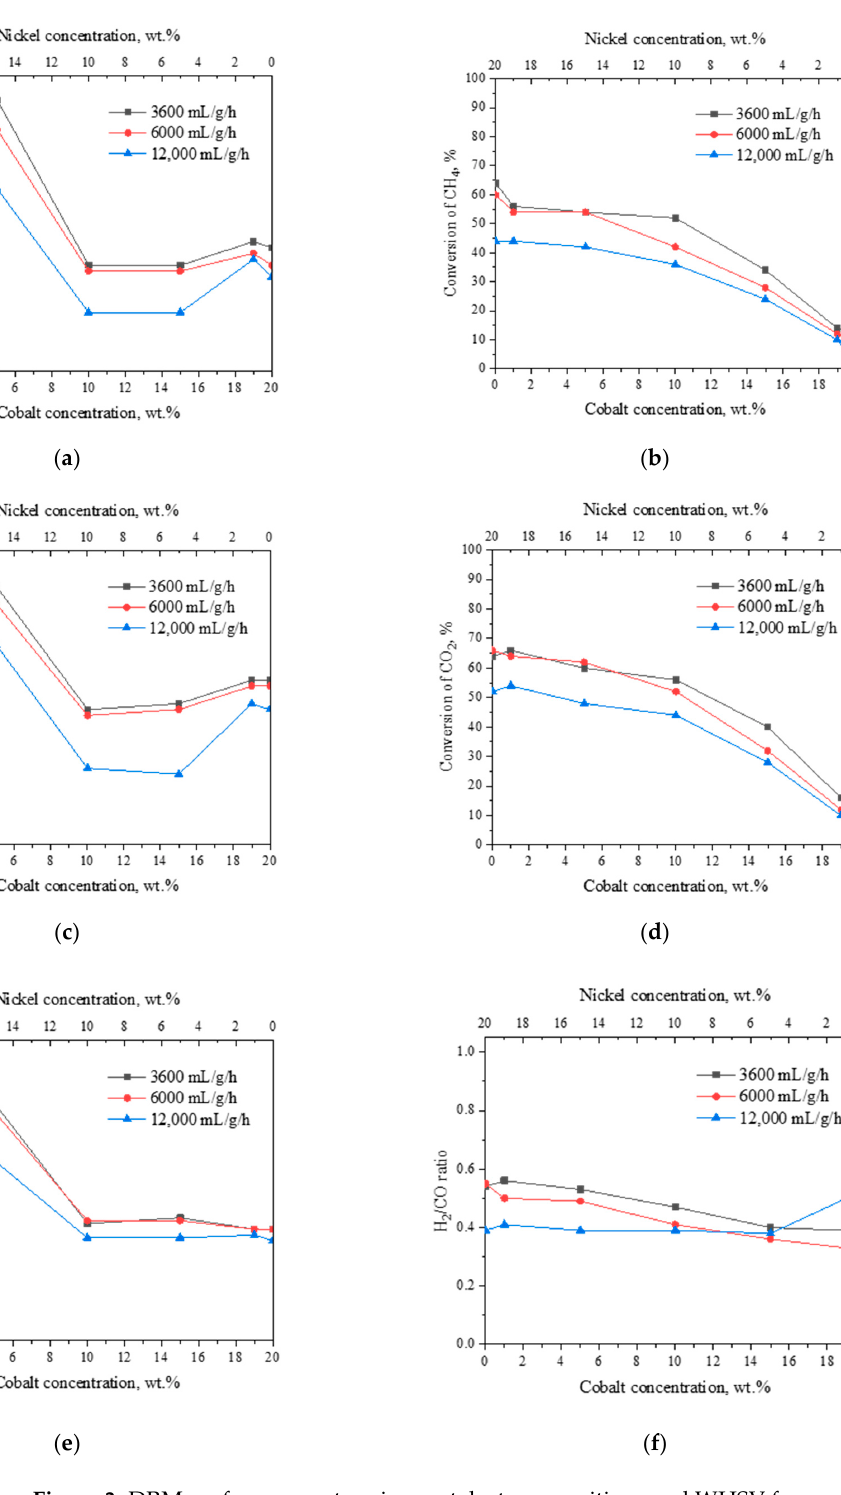
Figure 3. DRM performance at various catalyst compositions and WHSV for samples prepared by DP ( a , c , e ) and IWI ( b , d , f ) methods (T = 800 °C, P = 1 atm, CO 2 /CH 4 = 1).